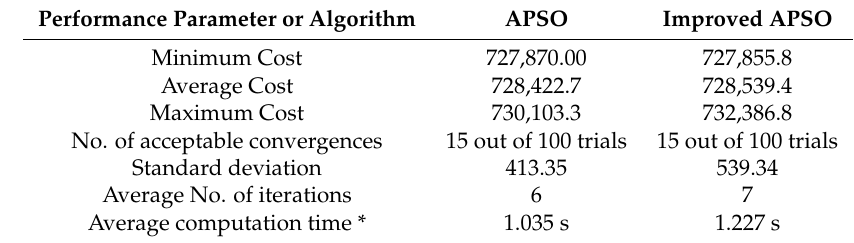
Table 6. Comparison of some performance parameters between APSO and the improved APSO on non-cascaded non-pumped STHTS